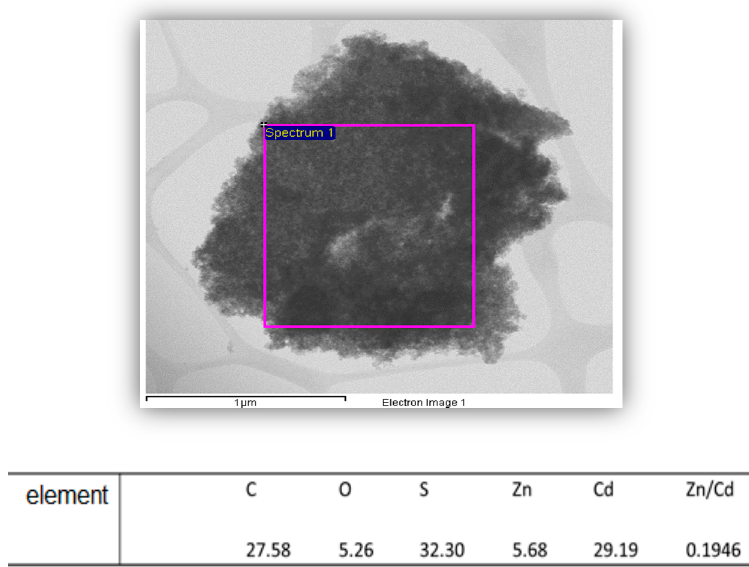
Figure 8. EDS-STEM for Zn 0.2 Cd 0.8 S solid solution with the elementary composition of the analyzed section .